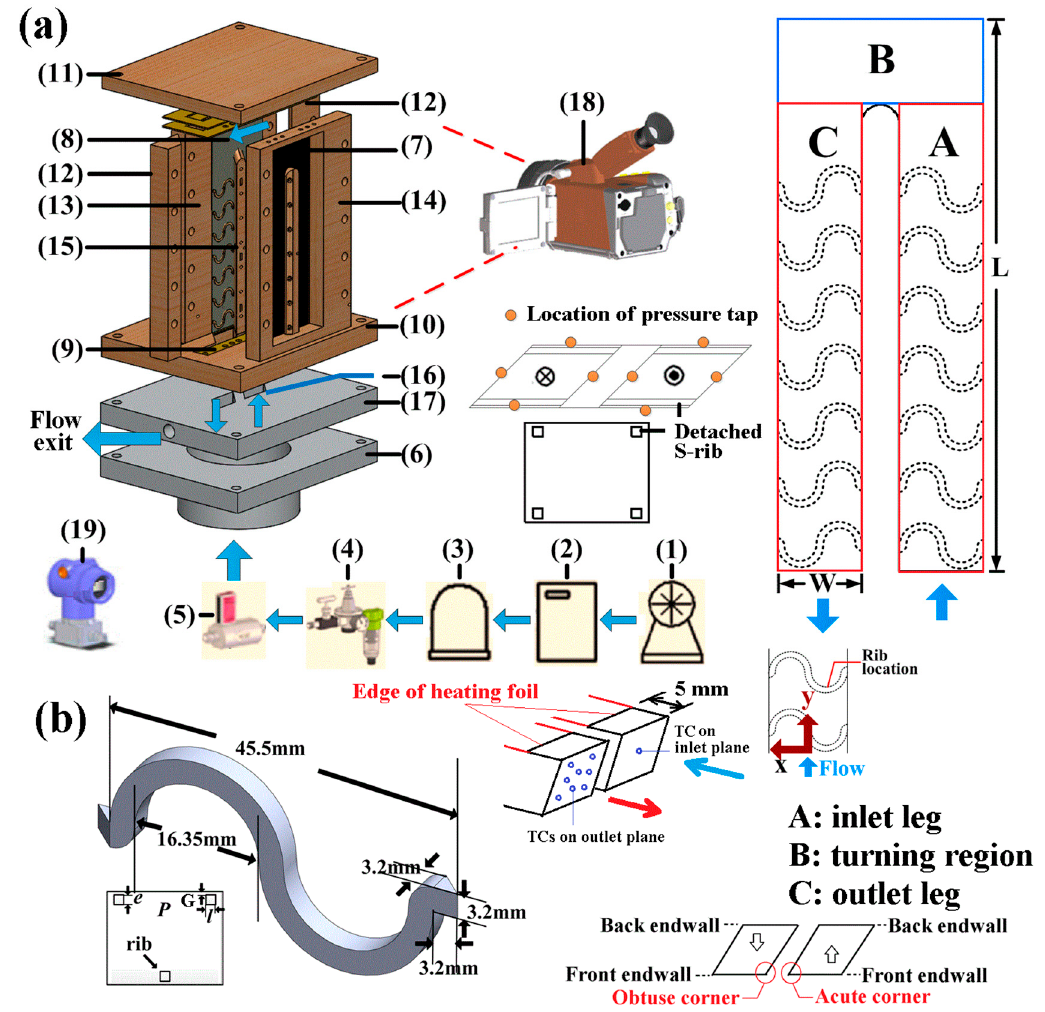
Figure 1. ( a ) Experimental facilities: (1) rotary compressor, (2) demudifier, (3) air tank, (4) needle valve, (5) mass flow meter, (6) cylindrical air plenum chamber, (7) and (8) stainless steel heating foils, (9) copper plates, (10) base plate, (11) top plate, (12) sidewall, (13) back wall, (14) front frame, (15) central divider, (16) thermocouple, (17) flow entry and exit flanges, (18) infrared (IR) camera, (19) digital type micromanometer. ( b ) configurations of S-rib.